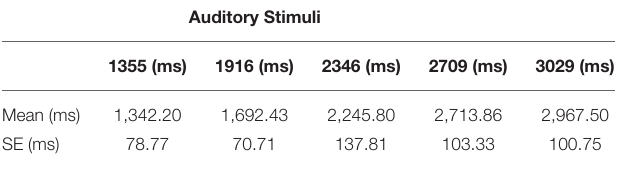
TABLE 2 | Descriptive statistics results of the time reproduction task.